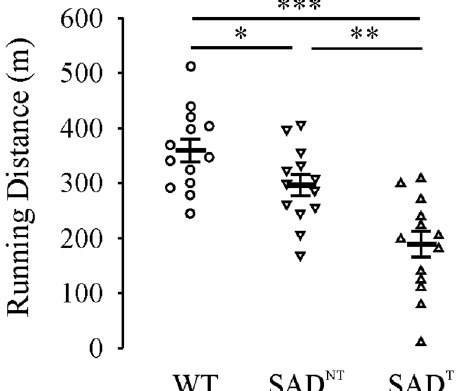
Figure 4. Decreased exercise capacity in SAD mice. Plots of running distance (m) for WT mice, SAD mice without tachypnea (SAD NT ) and SAD mice with tachypnea (SAD T ). * p < 0.05; ** p < 0.01; *** p < 0.001 using one-way ANOVA Holm-Sidak